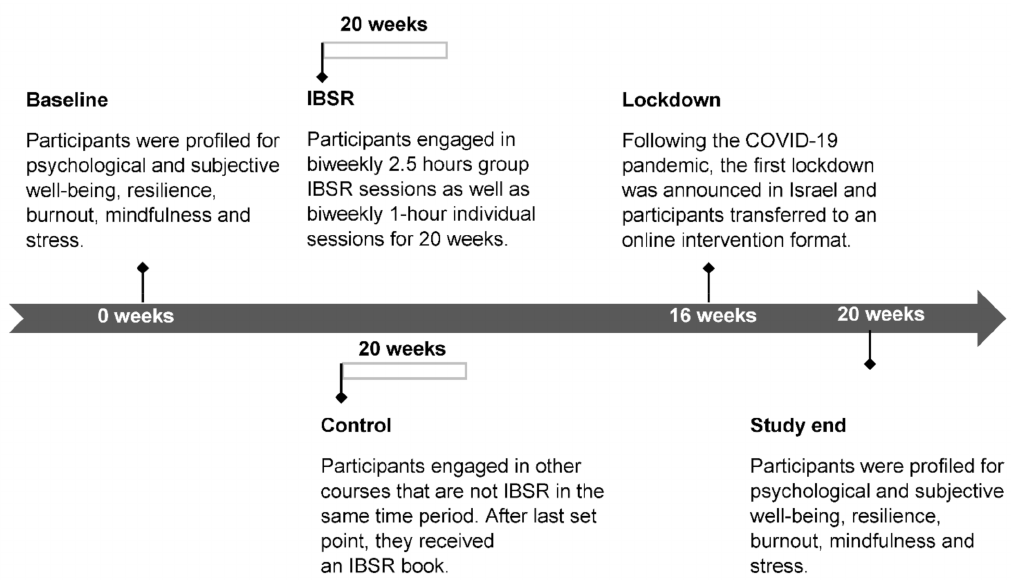
Figure 1. Study Timeline. Participants were profiled at baseline for psychological and subjective well-being, resilience, burnout, mindfulness and stress. They were engaged in IBSR or control and underwent either a 20-weeks IBSR training program or a 20-weeks waiting period. Psychological profiling and assessment of burnout were performed again at study week